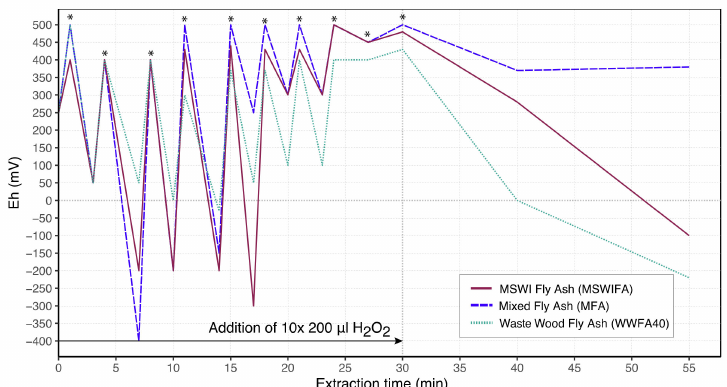
Figure 3. Evolution of redox potential (Eh) during laboratory experiment with H 2 O 2 . Left : Eh before and after each dose of H 2 O 2 (indicated with *). Right : evolution of Eh after the last H 2 O 2 dosage.